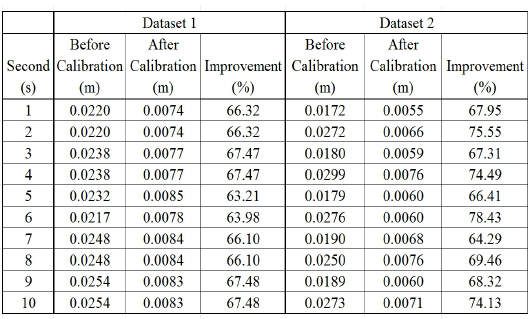
Figure 14. The standard deviations of the estimated Δ θ by the calibration for Dataset 1 over a 10 second period